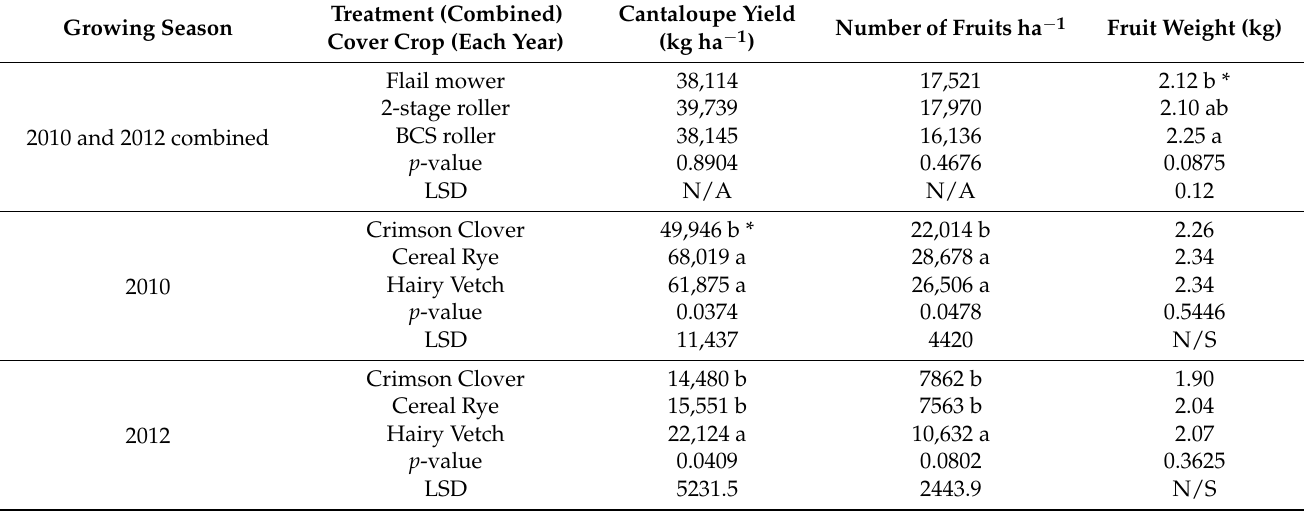
Table 14. Cantaloupe yield, fruit number, and fruit weight for rolling treatment (2010 and 2012 combined) and by each year for each cover